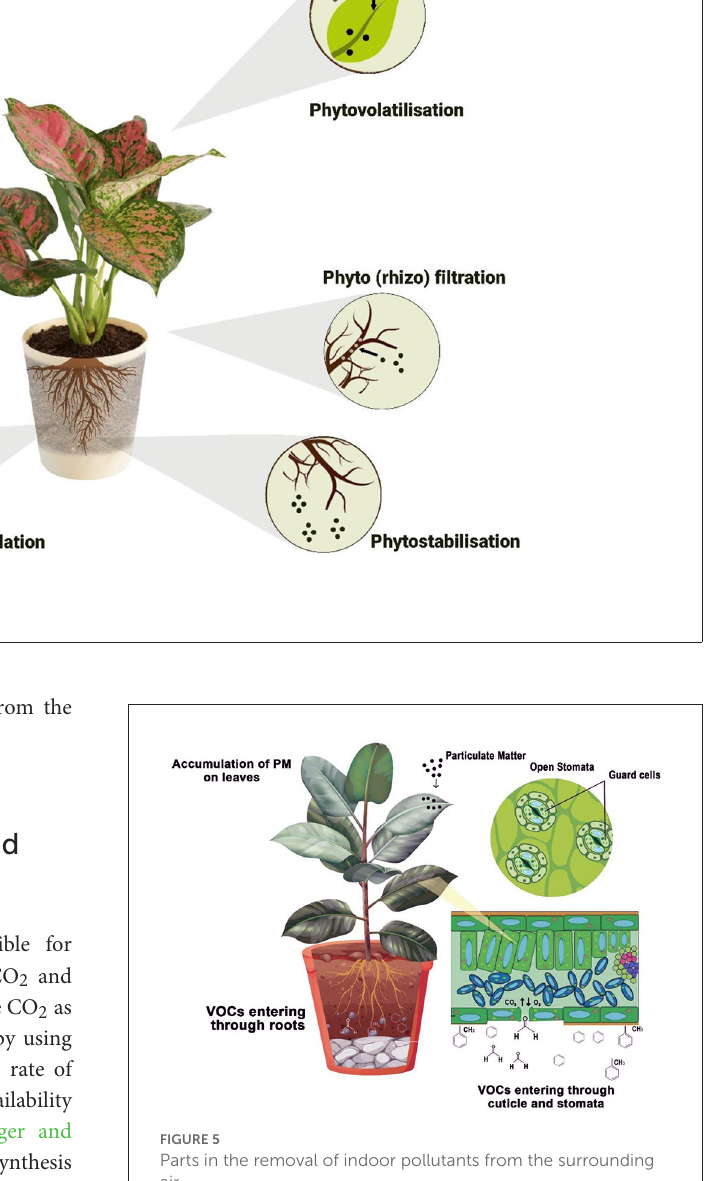
FIGURE5 Parts in the removal of indoor pollutants from the surrounding